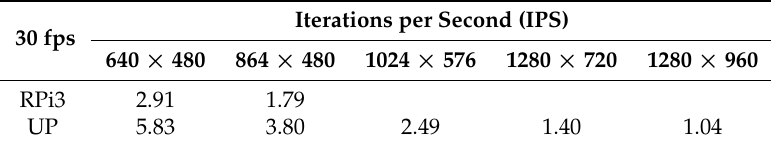
Table 5. IPS at 30